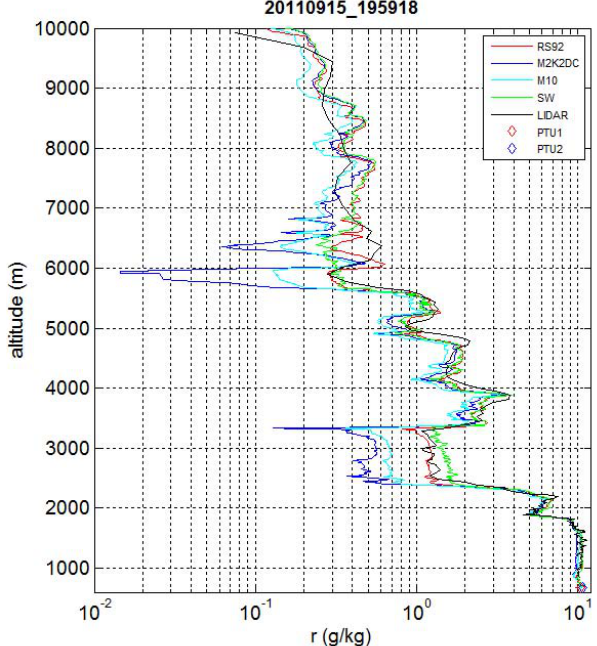
Fig. 13. Comparison of WVMR profiles on 15 September 2011. Ra- diosonde measurements are from balloon launched at 19:59UTC and IGN-LATMOS lidar profile is integrated from 19:53 to 19:58UTC. Surface measurements from PTU1 and PTU2 are added at the bottom of the profiles.